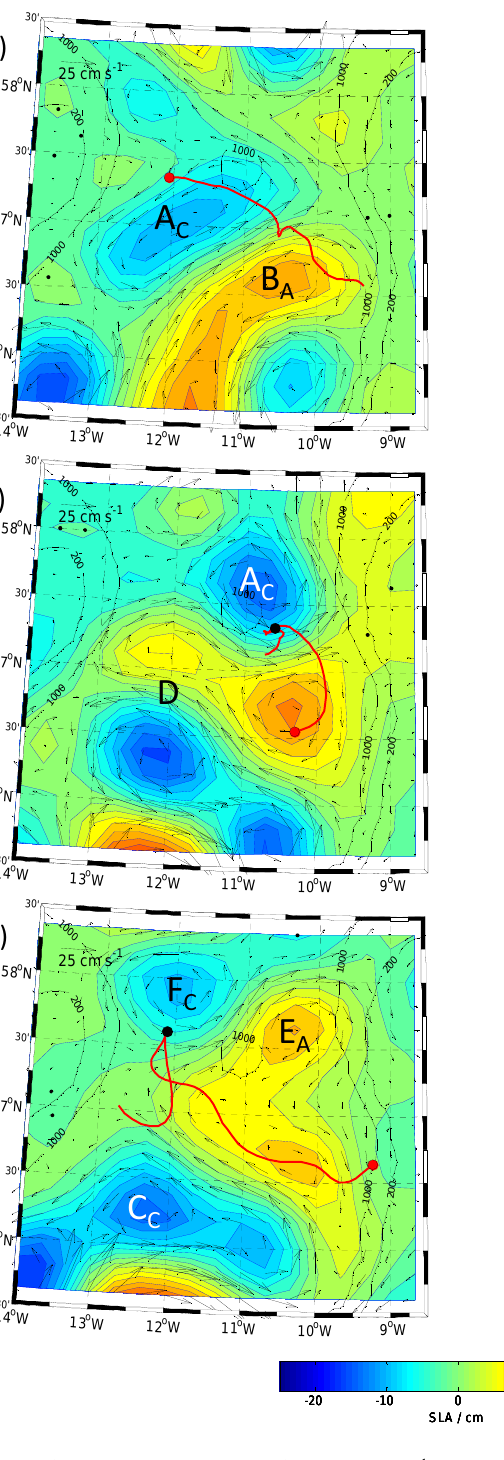
Figure 7. Snapshots of SLA and associated surface velocities (scaled by the 25cms − 1 arrow in the top left-hand corner) sampled every 27 days during Mission 1. (a) 20 October 2009; (b) 16 November 2009; (c) 13 December 2009; (d) 9 January 2010; (e) 5 February 2010; (f) 4 March 2010. Red lines are the track of the glider for 9 days before and after each snapshot (where appropriate), with the head indicating the end position. The black dots show the position of dives used to investigate the θS profiles of individual eddies (see Fig. 10). Each panel shows the anomaly about the area monthly mean to eliminate the colour shift due to the seasonal change in mean steric height. Isobaths are in